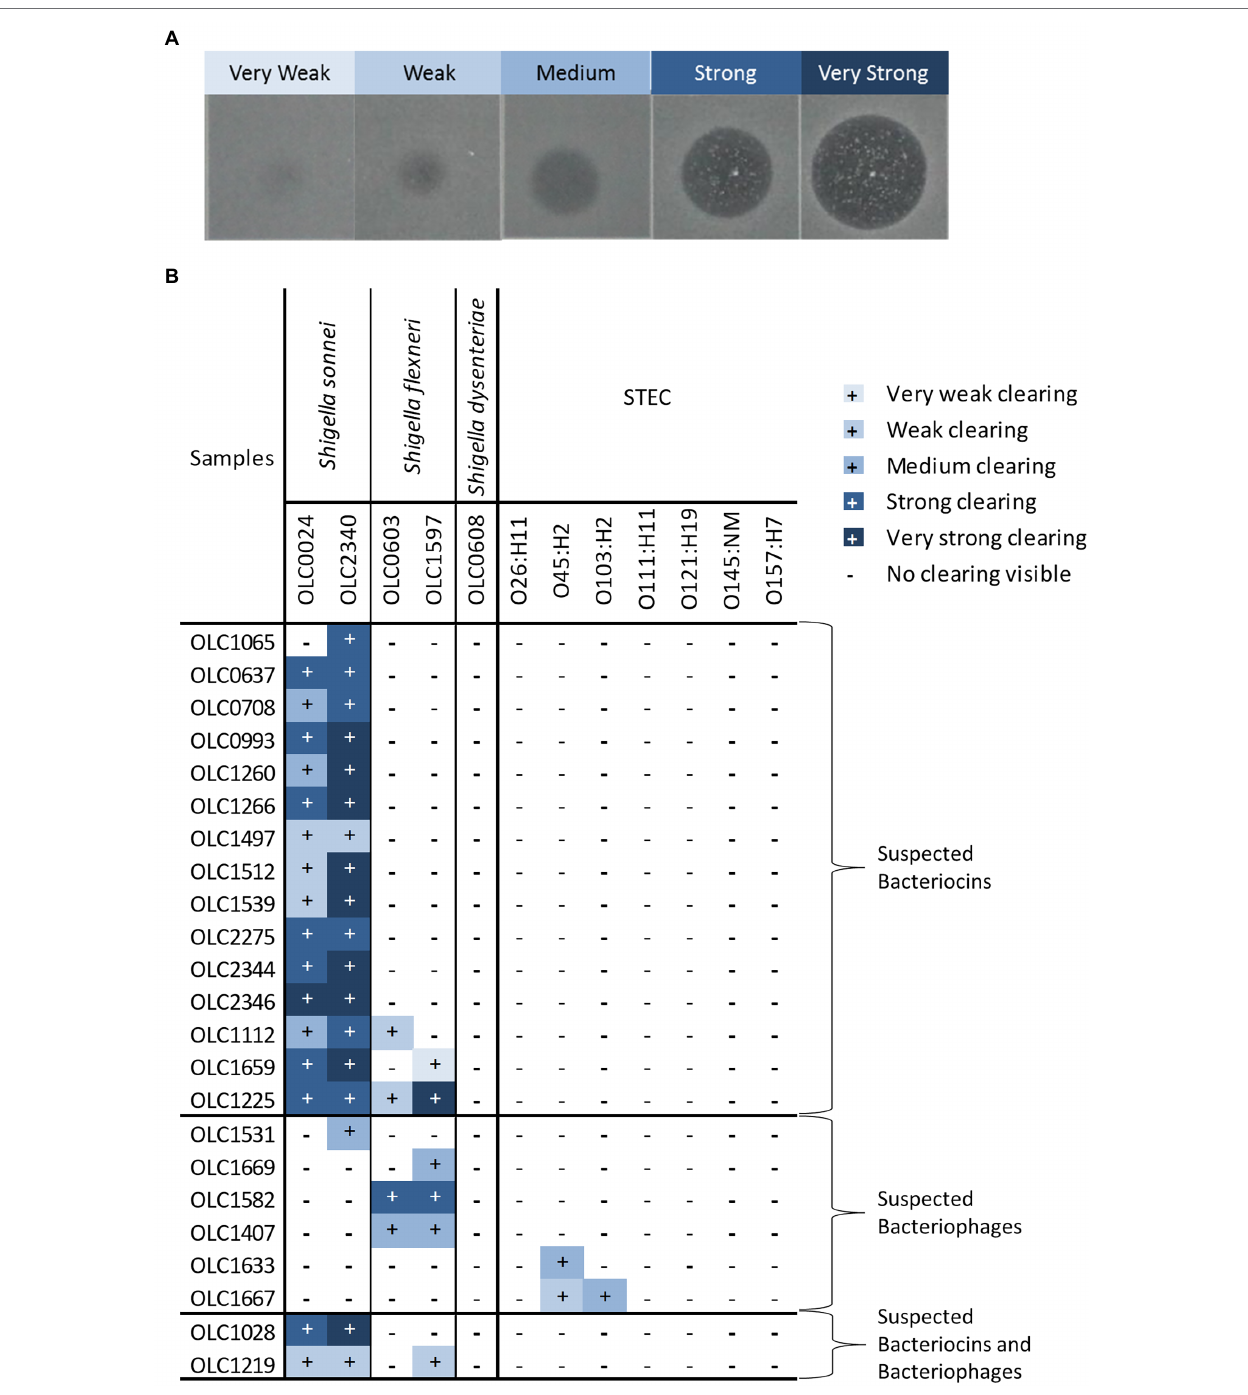
the zone of inhibition and the opacity of the clearing ( Figure 3A ). indicator organisms tested ( Figure 5 ; Supplementary Table S3 ).